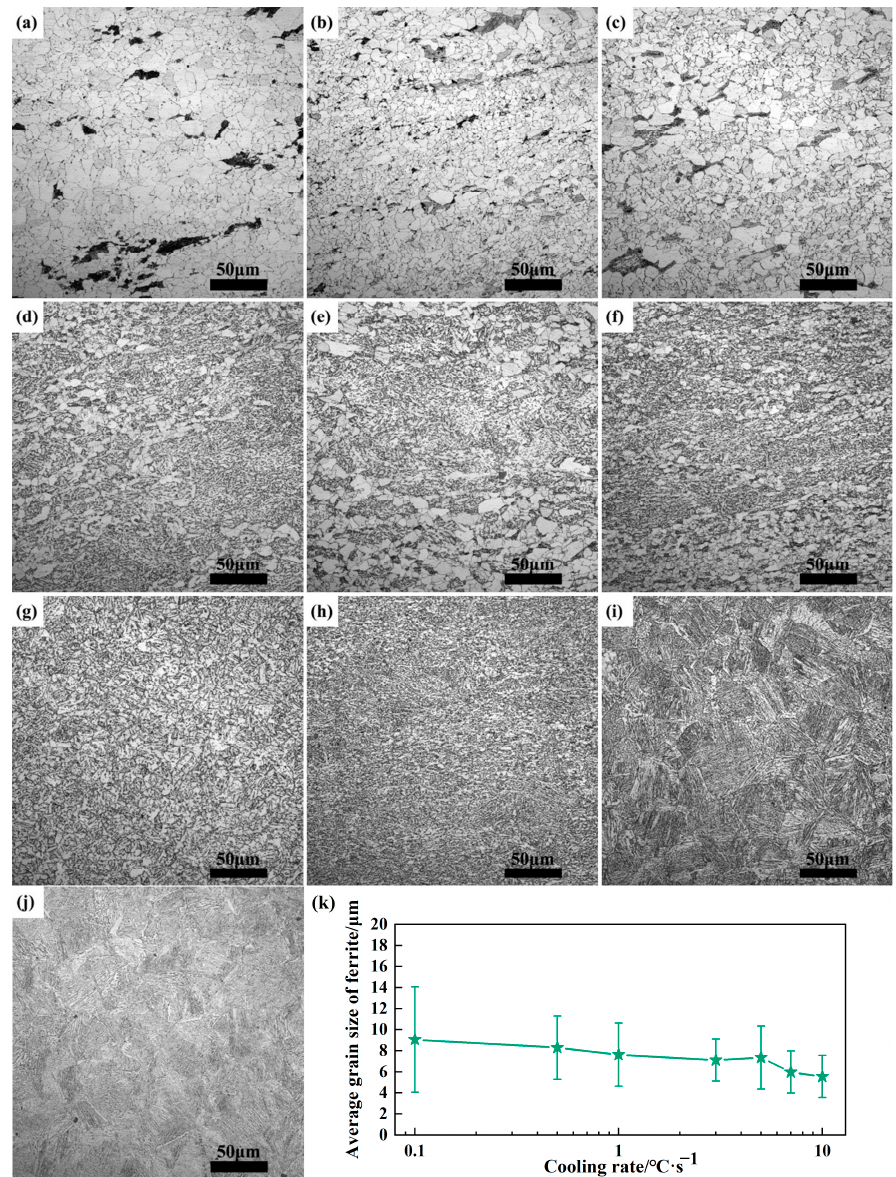
Figure 2. Microstructure of test steel at di ff erent cooling rates: ( a ) 0.1 °C/s; ( b ) 0.5 °C/s; ( c ) 1 °C/s; ( d ) 3 °C/s; ( e ) 5 °C/s; ( f ) 7 °C/s; ( g ) 10 °C/s; ( h ) 20 °C/s; ( i ) 30 °C/s; ( j ) 50 °C/s; ( k ) average grain size of ferrite at di ff erent cooling rates.